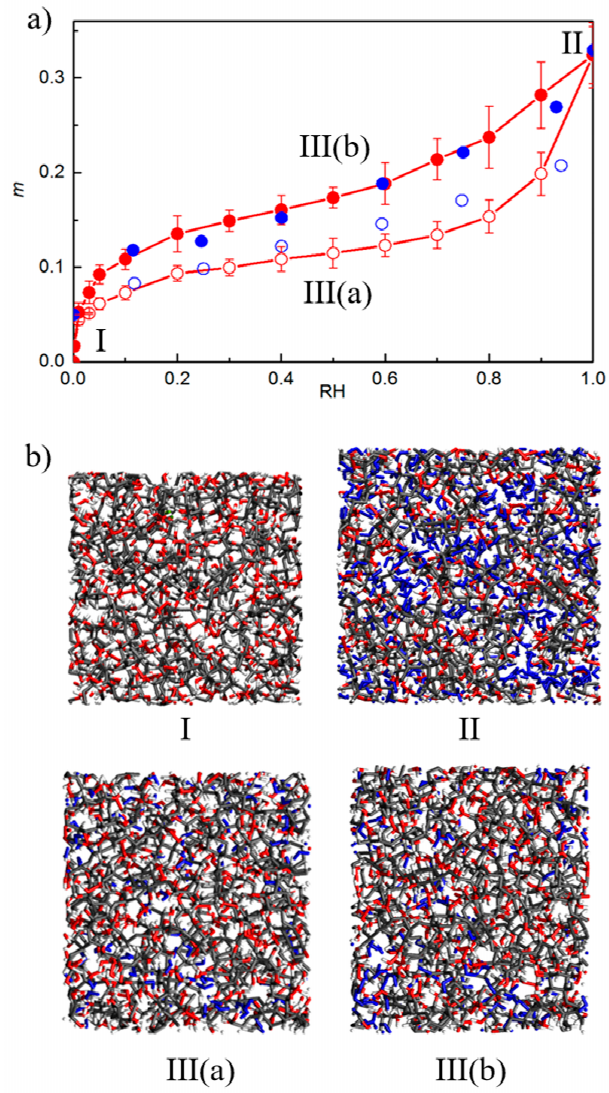
Figure 7. ( a ) Water sorption isotherms at T = 300 K in cellulose: (red circles) hybrid GCMC / MD molecular simulation, (blue circles) sorption experiment from Reference [108]. The experimental data were shifted up by m = + 0.05 to account for the presence of residual, i.e., non-desorbable water, in the dried material. Open and closed symbols are adsorption and desorption data, respectively. The adsorbed amount is expressed as a moisture content m defined as the mass of water per mass of dry material. The error bar represents the standard deviation. ( b ) Snapshots of molecular configurations at different conditions: I, the dry state (RH = 0); II, the saturated state (RH = 1); III(a), adsorption at RH = 0.5; III(b), desorption at RH = 0.5.